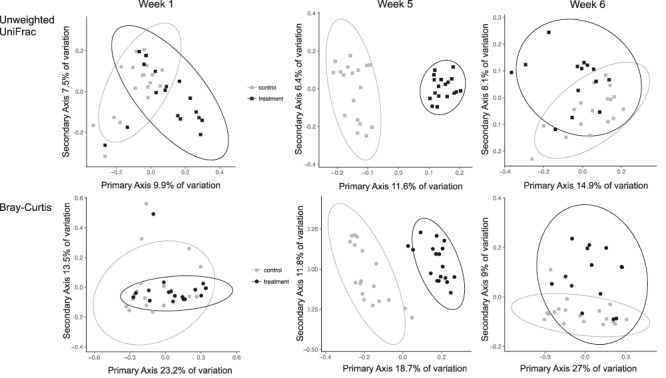
PCoA plots depicting beta diversity comparisons between treatment and control hellbenders (Cryptobranchus a. alleganiensis) at Weeks 1, 5 and 6. Gray points depict control individuals (squares = unweighted UniFrac, circles = Bray–Curtis), and black points indicate treatment individuals (squares = unweighted UniFrac, circles = Bray–Curtis). Ellipses illustrate overlap in community composition between the two hellbender groups. There is strong overlap between control and treatment individuals at the beginning of the experiment and after all hellbenders are released into the river (Weeks 1 and 6). However, there is a strong differentiation between groups at Week 5, when treatment hellbenders are bathed in undiluted river water